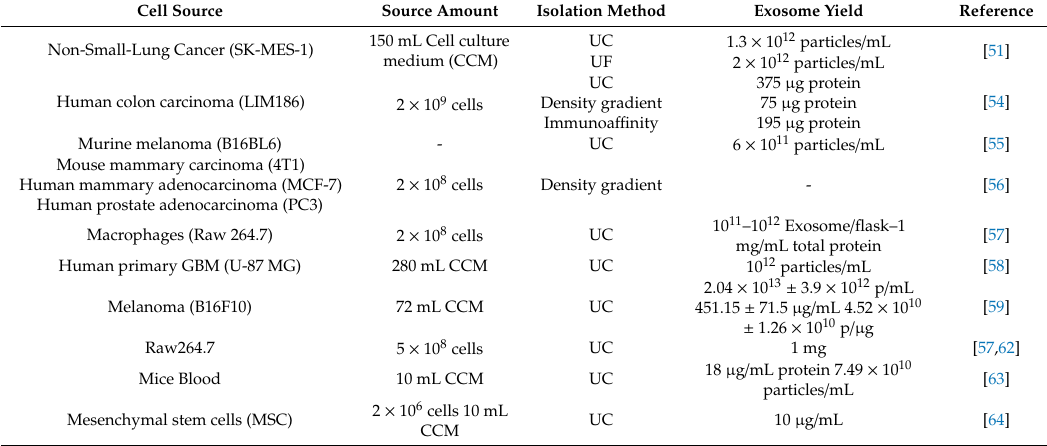
Table 1. Exosome quantification in term of particles and µ g of protein per mL significantly changes according to the isolation method, cell source, and source amount. This highlights the absence of a standardized method to obtain a homogeneous